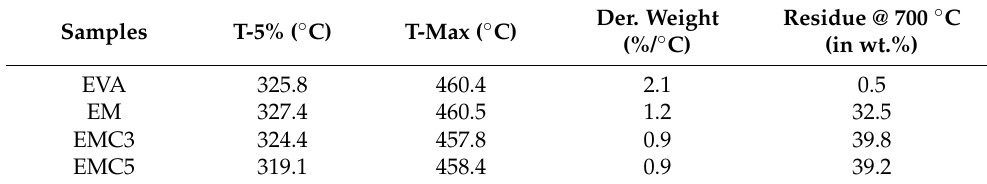
Table 5. TGA results of the composites.